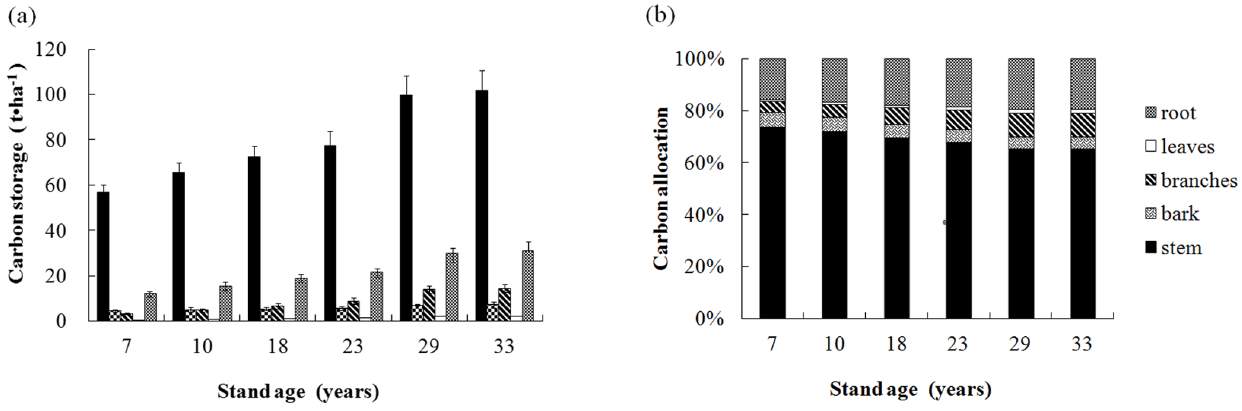
Figure 1. Carbon stocks and their allocation to tree components in six differently aged Mytilarialaosensis stands. Values in (a) are means 6 SE, n=4. Note: Different lowercase letters above the bars indicate significant differences between means (multiple comparisons test; P , 0.05).